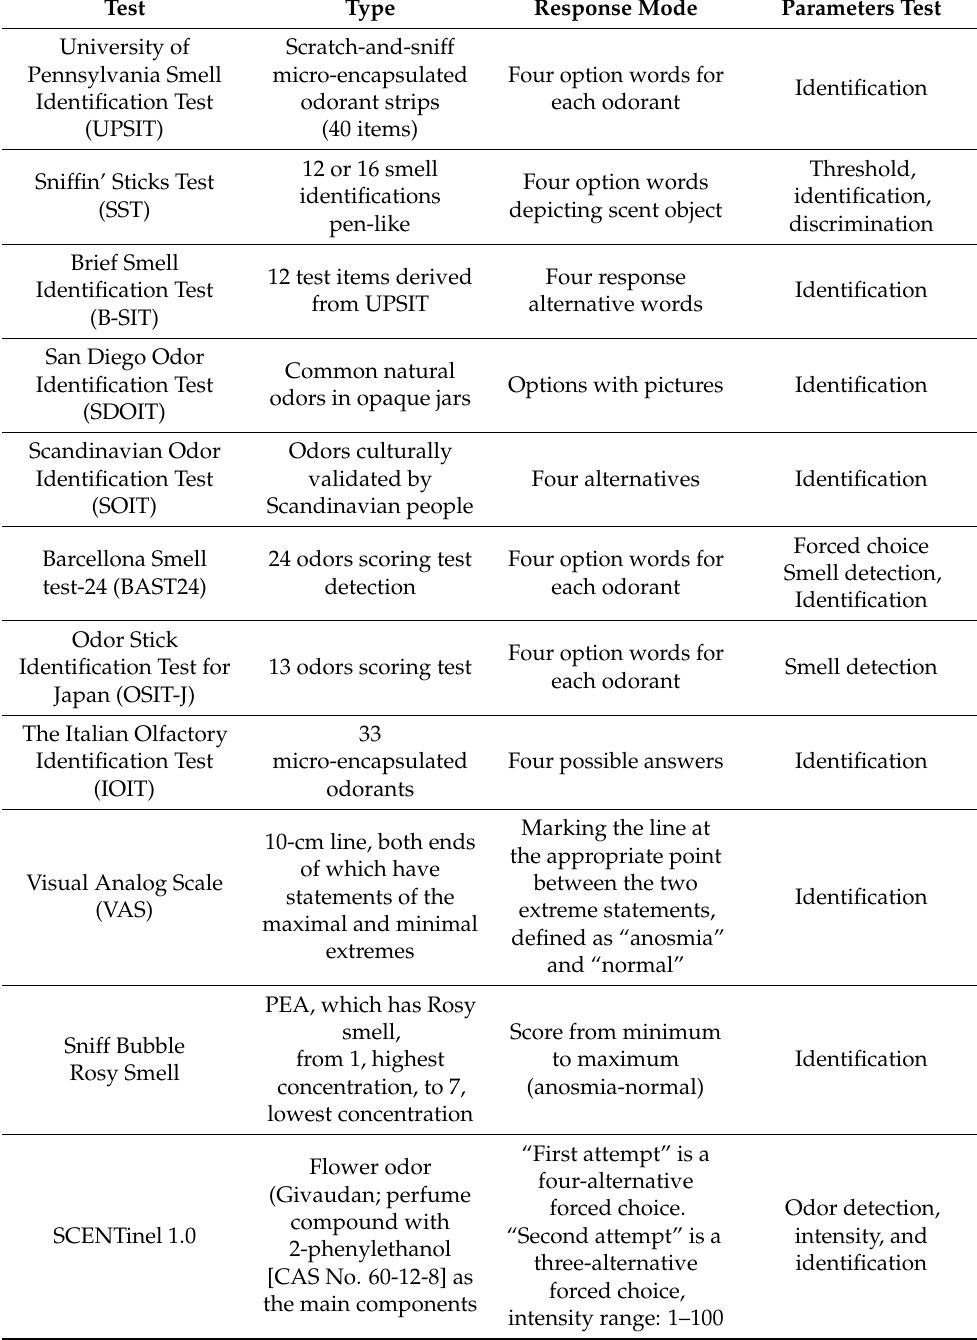
Table 2. Main tests for olfactory function and their clinical